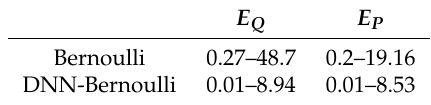
Table 4. Comparison of error range between Bernoulli and DNN-Bernoulli